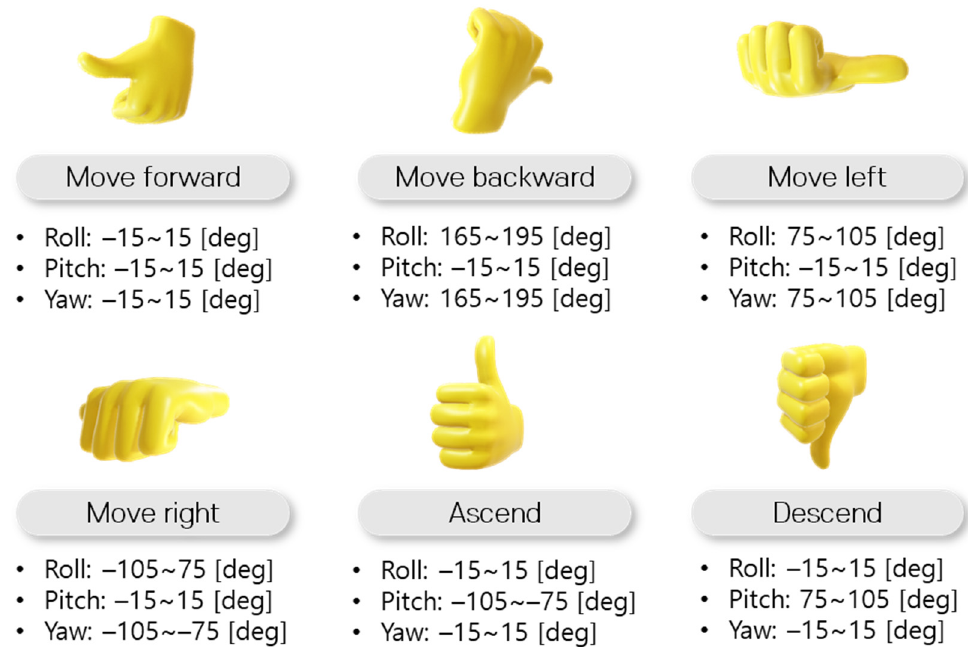
Figure 5. Configuration of the orientation range of the thumb for recognizing each dynamic gesture.